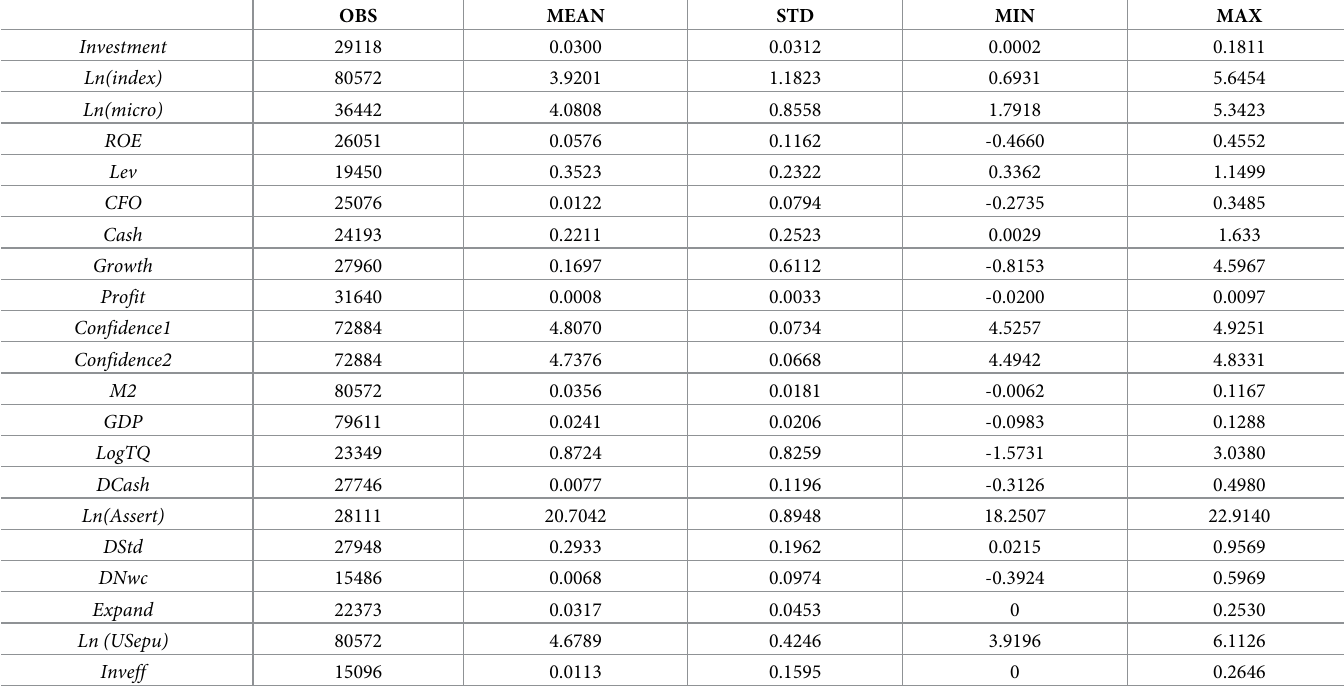
Table 3. Descriptive